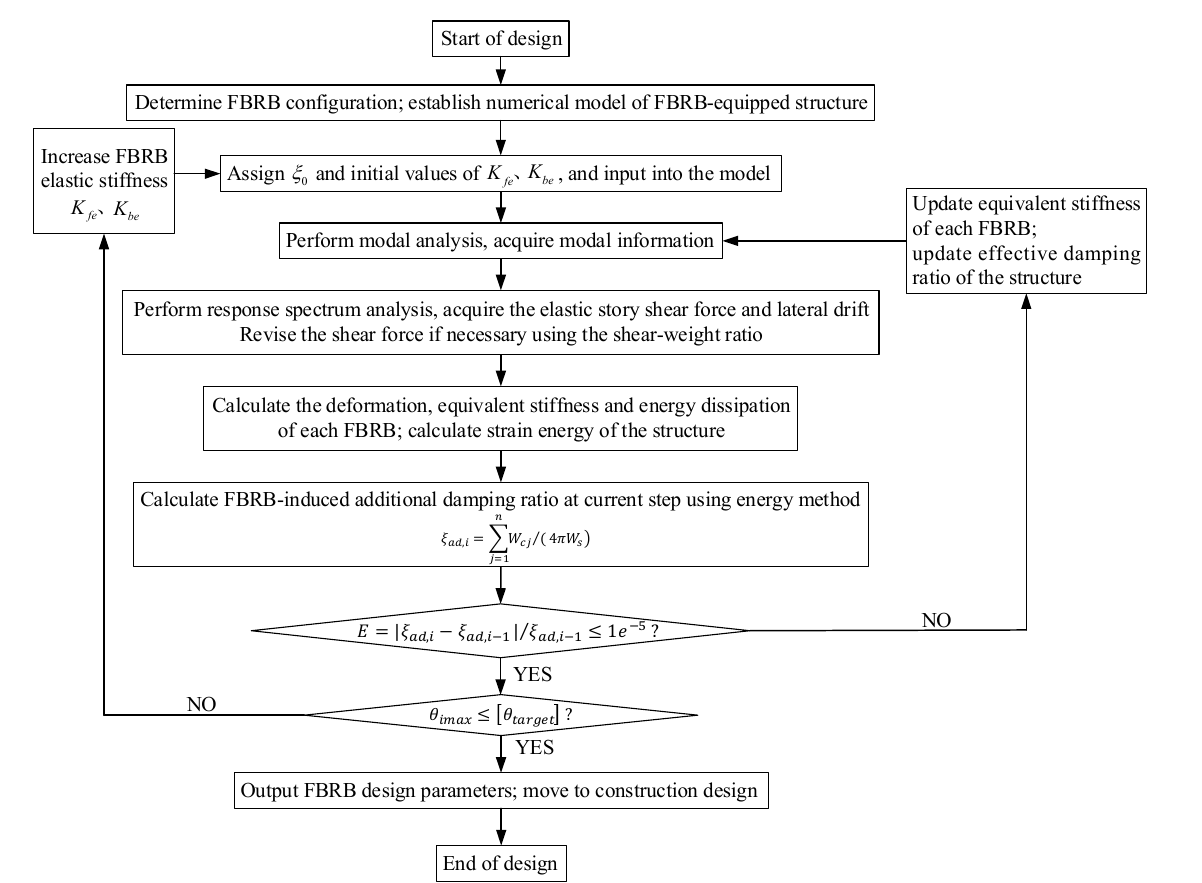
Figure 11. Parametric design procedures for FBRB ‐ equipped structures.